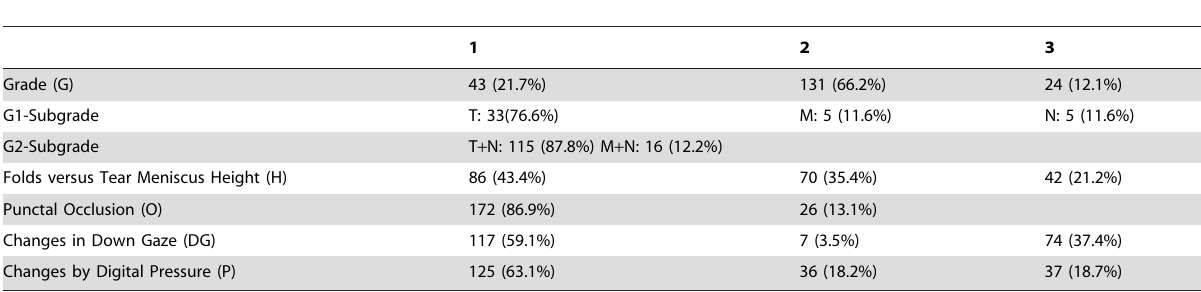
Table 5. The classification of participants with